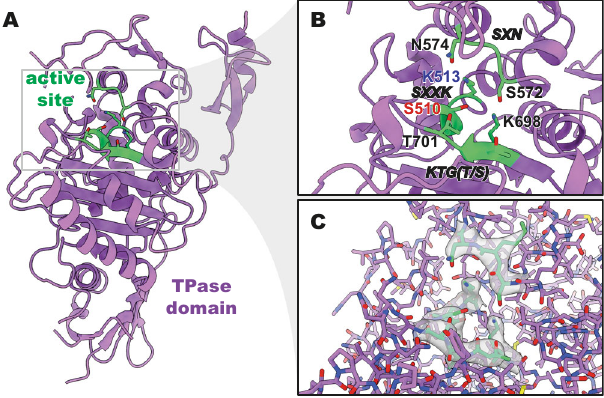
Fig. 3 Transpeptidase domain of apo PBP1b. A An overview of the structure transpeptidase domain (TPase — purple). The SXXK , SXN and KTG (T/S) motifs of the active site are in green, with the active site region boxed in grey. B A close-up of the active site of the TPase domain of PBP1b. The motifs, as in ( A ), are in green. The SXXK motif contains both the serine nucleophile (S510 — red) and the general base lysine (K513 — blue). The SXN motif is involved in the protonation of the nitrogen leaving group during acylation, while the KTG(T/S) motif forms the oxyanion hole and is involved in substrate binding. C The active site view, as in ( B ), in stick representation along with the transparent cryoEM map of PBP1b around the active site residues. Despite the modest resolution for the overall structure (3.28 Å), the density of the TPase domain-active site is above the mean (at ~3.1 – 3.2 Å) due to its recessed location and the overall higher local resolution observed for the TPase domain (Supplementary Fig. 3).